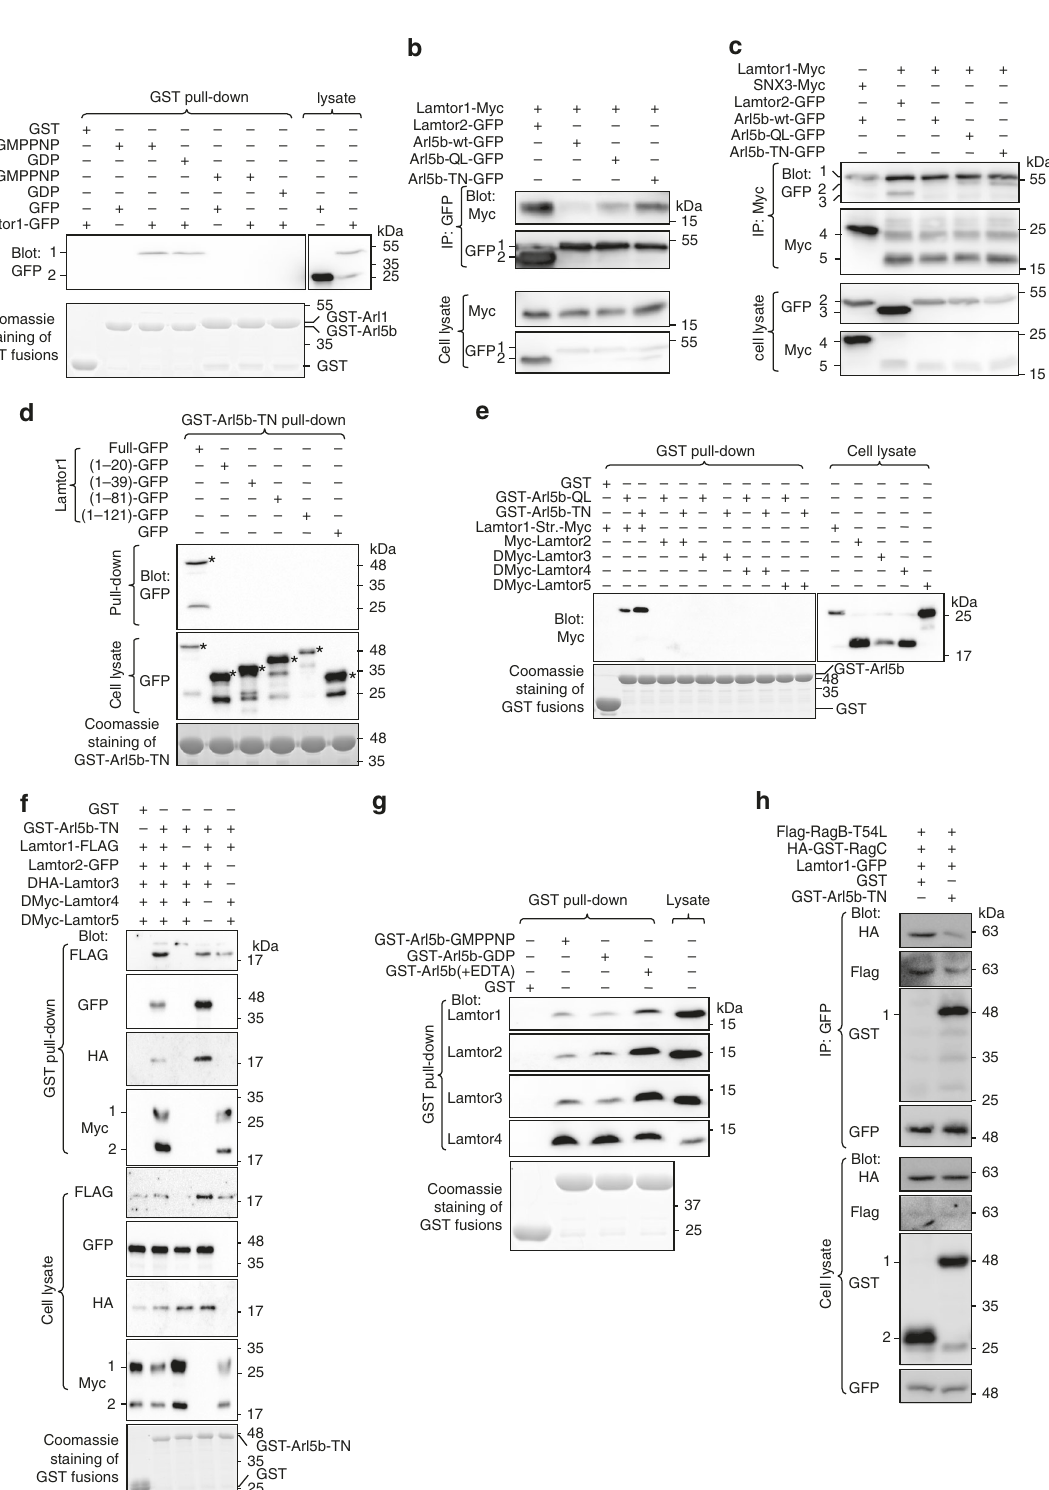
Fig. 4b). Using puri fi ed cDNA plasmids as calibration